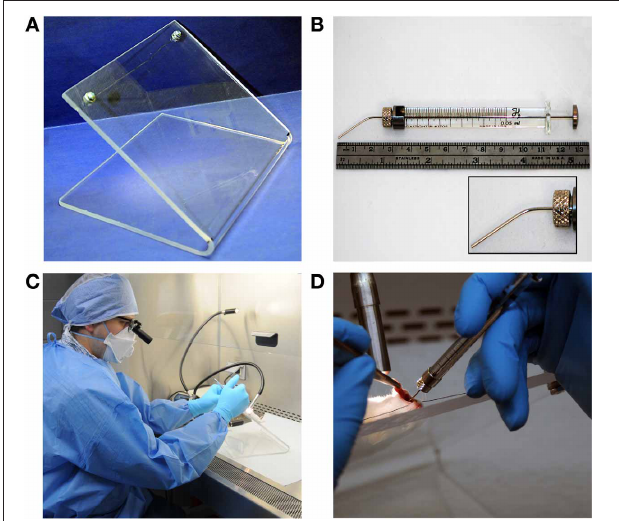
FIGURE 1 | Equipment. (A) Backboard constructed of plexiglass with wire strung between screws. (B) Gastight syringe (50 µ l total volume) with bent and blunted 22s gauge needle. (C) General equipment arrangement within a biosafety cabinet. (D) Instillation procedure with lightsource placement, withdrawn tongue, and placement of the gastight